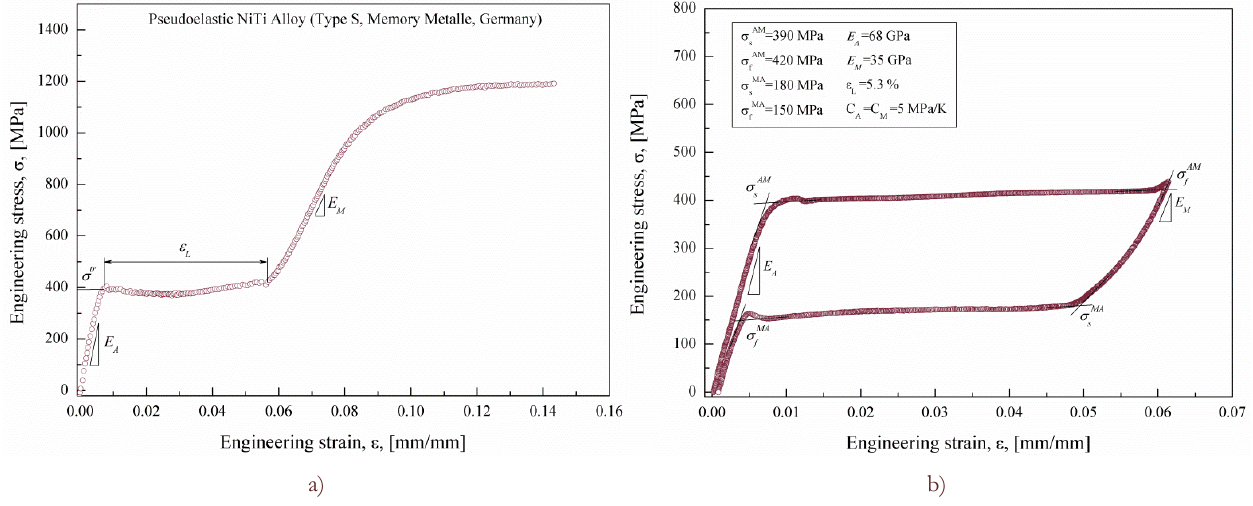
Figure 3: Isothermal stress-strain curve of the investigated alloy carried out at room temperature (T=298k): a) monotonic loading to fracture and b) loading-unloading cycle.